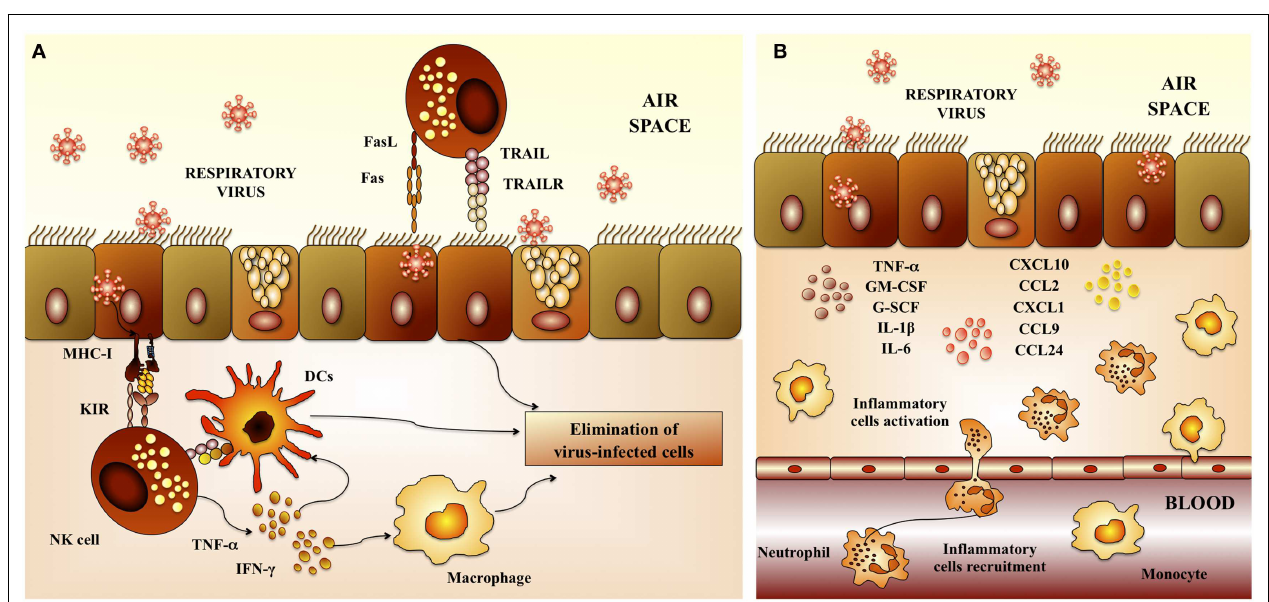
FIGURE 2 | Respiratory anti-viral innate immune response . (A) Activity of natural killer cells. Natural killer (NK) cells are involved in the elimination of virus-infected cells because of their cytotoxic capacities. NK cells are recruited to the lungs early after respiratory virus infection. Dendritic cells (DCs) potentiate NK-cell activation and cytotoxicity. In addition, alveolar macrophages are also required to activate NK cells. (B) Inflammatory response. Epithelial cells and macrophages are crucial in the innate immune response to respiratory virus. Several chemokines and cytokines including